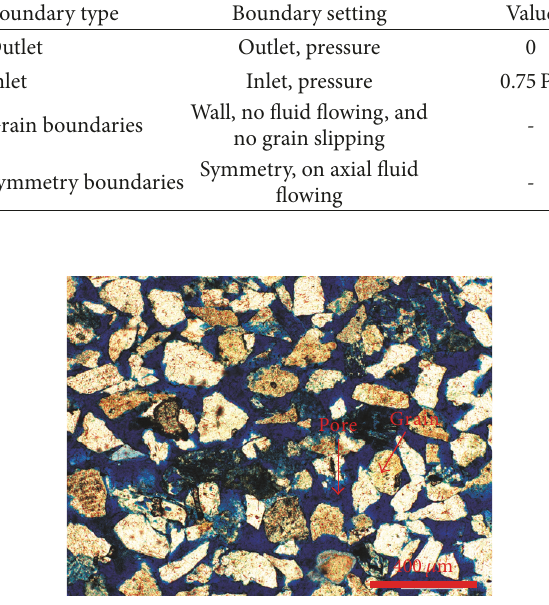
Figure 4: Image of cast Sample 2.